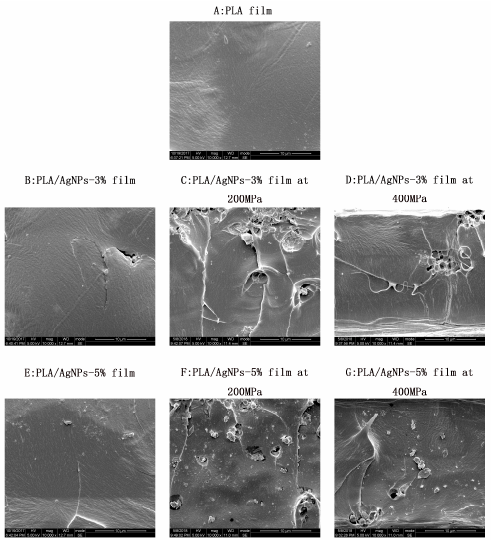
Figure 1. Effect of high pressure treatment on the microstructure of poly (lactic acid) ( PLA)/silver nanoparticles (AgNPs) nanocomposite films (magnification: 10,000×): ( A ) PLA film; ( B – D ) PLA/AgNPs-3 film treated at 0, 200 and 400 MPa, respectively; ( E – G ) PLA/AgNPs-5 film treated at 0, 200 and 400 MPa,